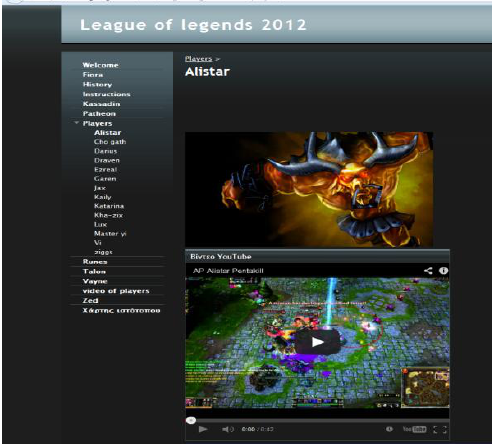
Figure XVI. League of Legends